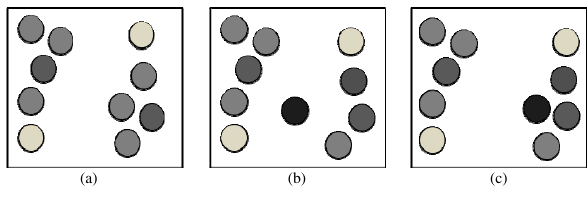
Fig. 9. Law of proximity.